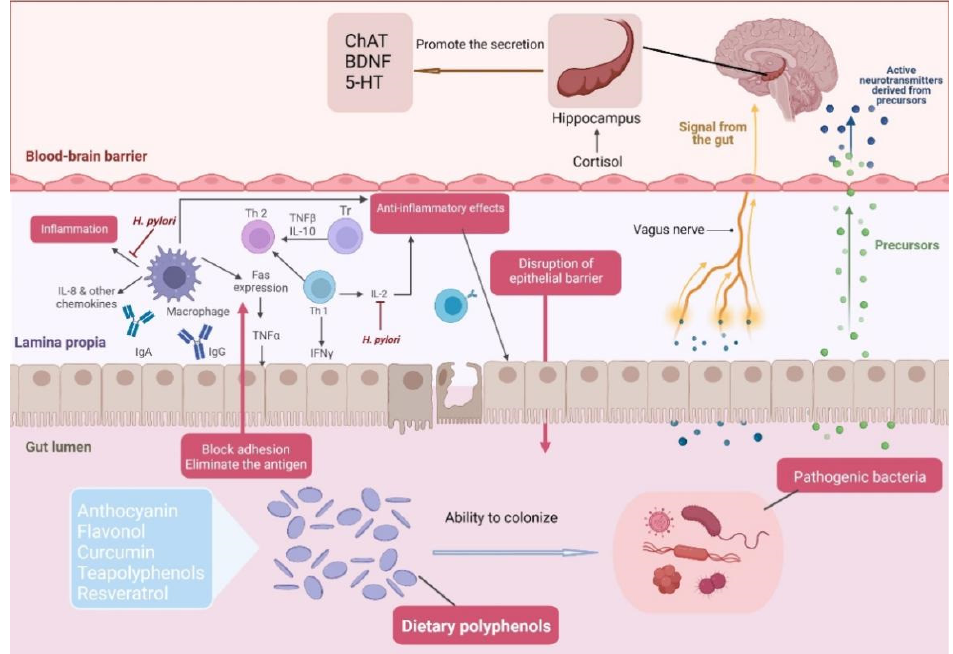
Figure 2. Dietary polyphenols promote the growth and reproduction of probiotics, maintain intestinal micro-ecological balance, improve immunity, induce gut-brain neurotransmitter signalling and stimulate the hippocampus to protect the health of the central nervous system.